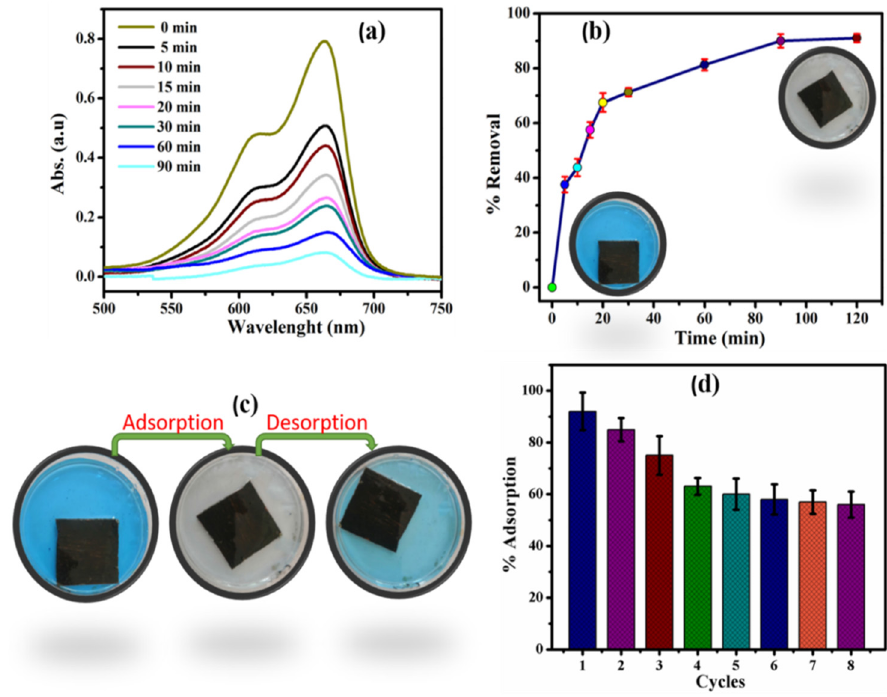
Figure 8. ( a ) Absorption vs. wavelength spectra for MB. ( b ) Adsorption% of MB through time. ( c ) Adsorption–desorption of MB and ( d ) cyclic performance of cement–DEES coatings (ref. [77]).